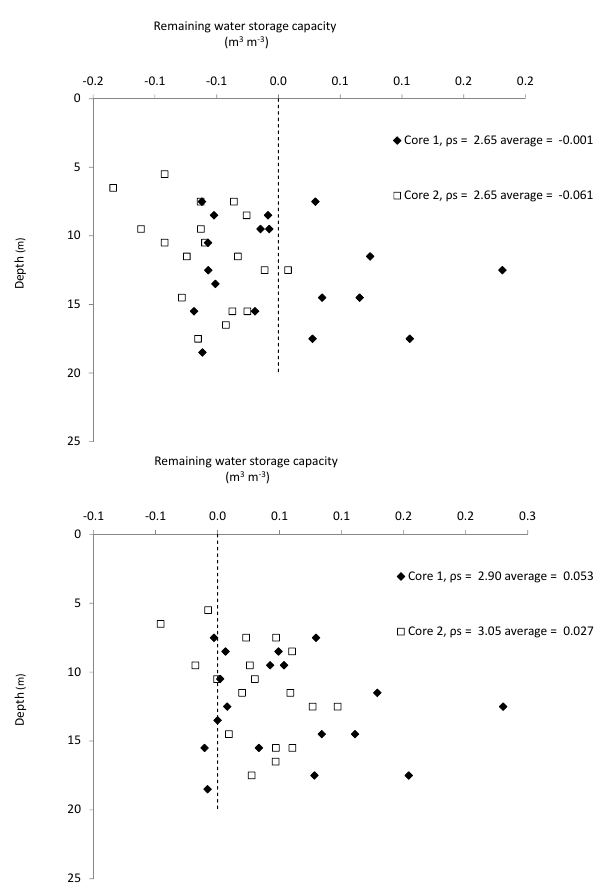
Fig. 6. Remaining water storage capacity for site D1 (Core 1) and site D3 (Core 2), calculated from bulk density, moisture content and (a) assumed particle density of 2.65tm − 3 and (b) assumed particle density of 2.90 and 3.05tm − 3 .